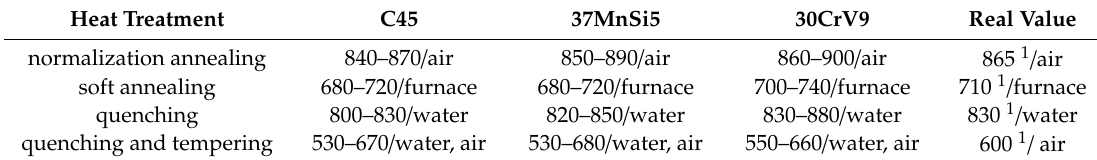
Table 2. The heat treatment: recommended and real (last column)